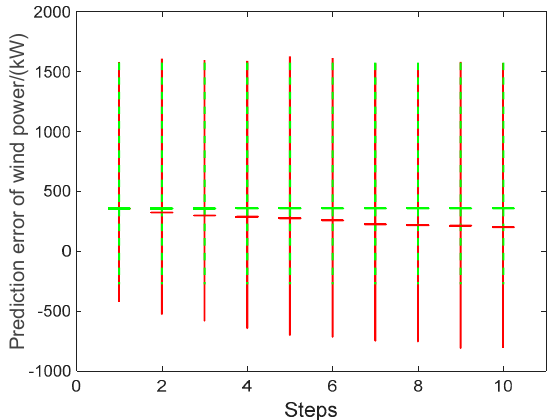
Figure 14. Error statistic of ten-step wind power prediction using actual and estimated wind speed via KDE method (Red line: Estimated data; Green dotted line: Actual data).